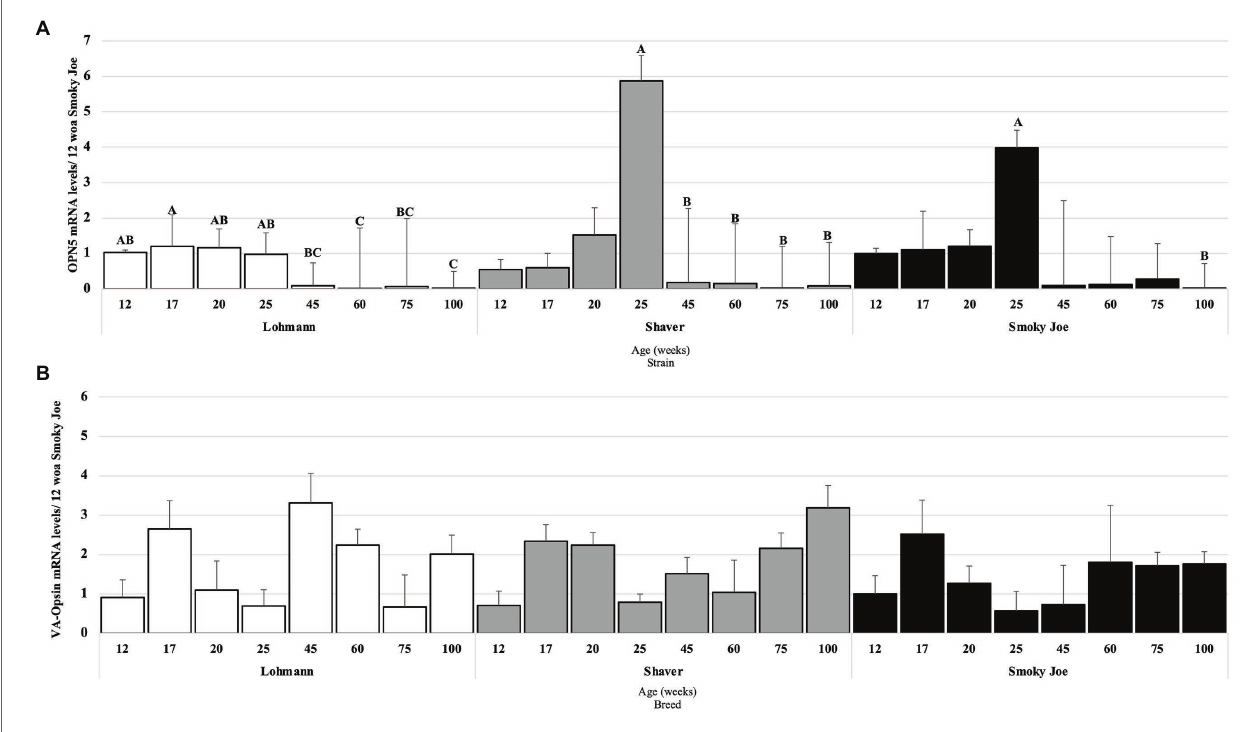
FIGURE 6 | Opsin 5 (OPN5; A ) and vertebrate ancient (VA)-Opsin (B) mRNA expression levels in Lohmann, Shaver, and Smoky Joe hens at 12, 17, 20, 25, 45, 60, 75, and 100 woa. p -values for the sources of variation of age by strain: (A) Lohmann, p < 0.0001; Shaver, p = 0.0029; and Smoky Joe, p = 0.0143. (B) Lohmann, p = 0.0502; Shaver, p = 0.00396; and Smoky Joe, p = 0.6476. A,B,C Data points lacking the common superscript differ significantly within the ages of each strain, while no superscript did not differ from any other time point in that